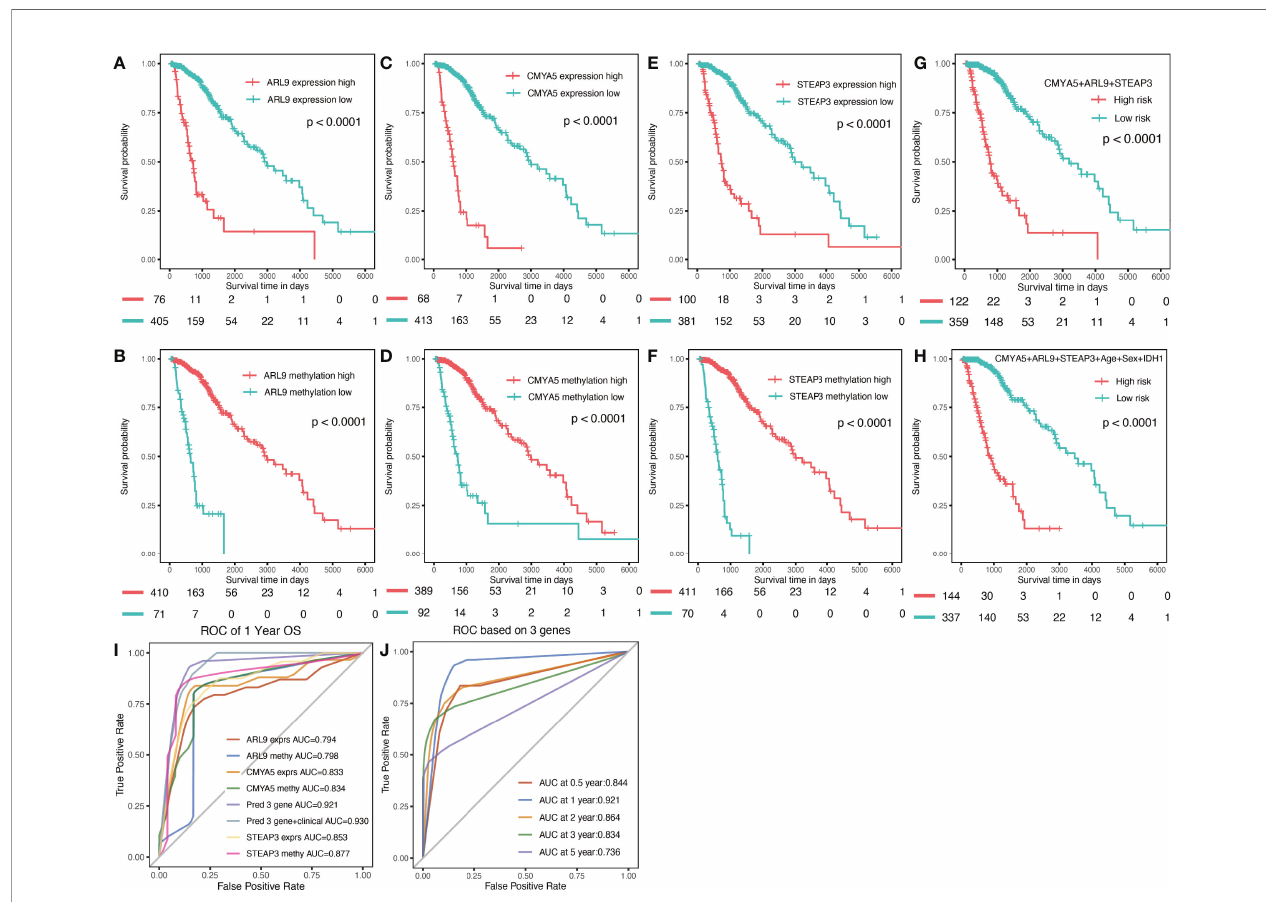
FIGURE 5 | Prognostic analysis of three genes individually and in combination for the whole TCGA dataset. (A, C, E) K-M OS curves based on expression levels for the three genes. (B, D, F) based on DNA methylation data. (G) based on expression and methylation data. (H) based on 3-gene signature with clinical parameters. (I) Multi-index ROC curve of indicators (J) Time-dependent ROC analysis the of the 3-gene